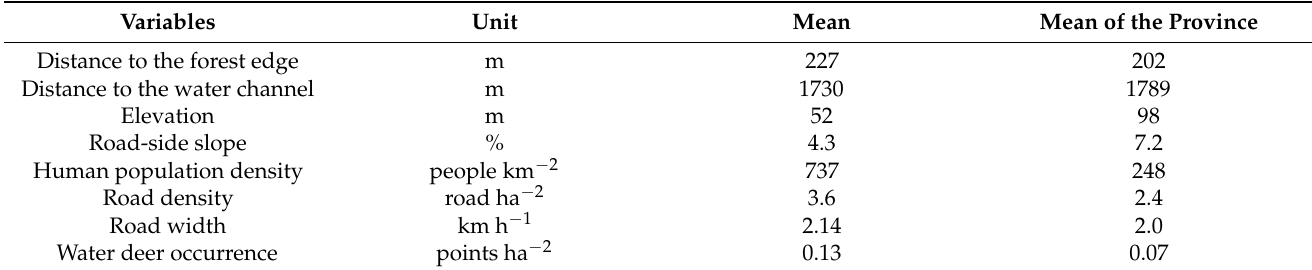
Table 2. Description of water deer roadkill reporting